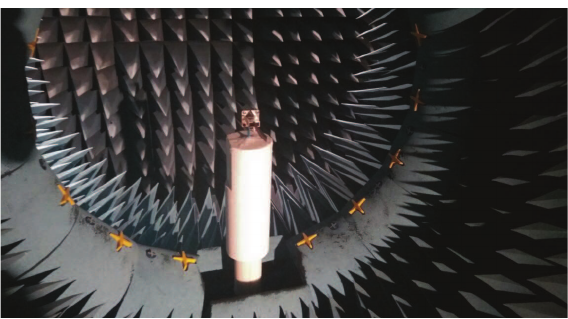
Figure 11. Experimental setup in the anechoic